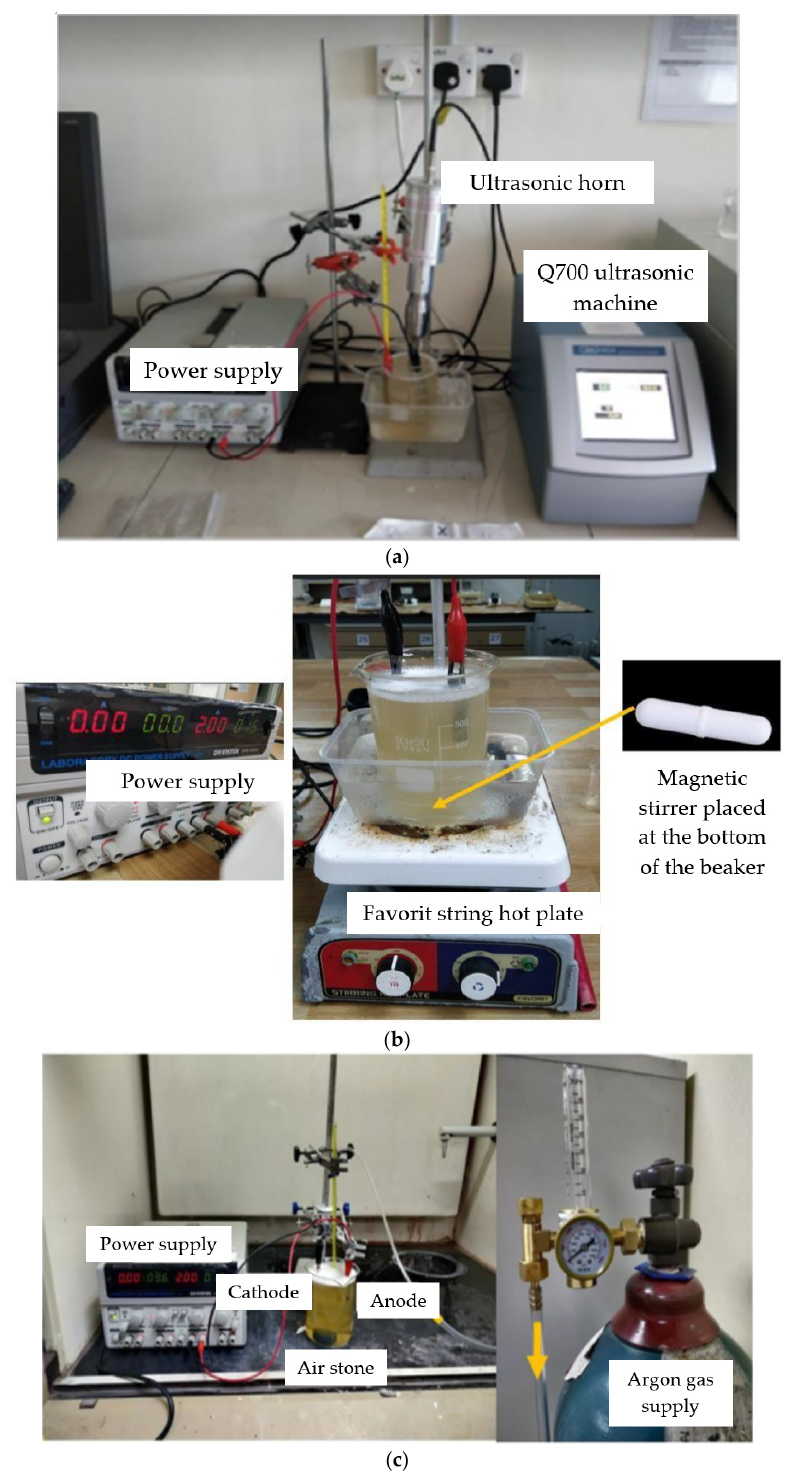
Figure 7. The experimental setup for three dispersion methods: ( a ) Ultrasonic agitation ( b ) magnetic agitation ( c ) Argon gas